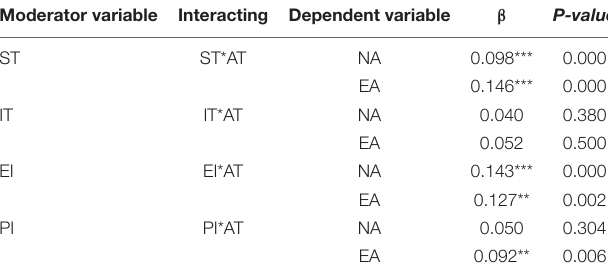
TABLE 6 | Results of the moderating effect. Moderator variable Interacting Dependent